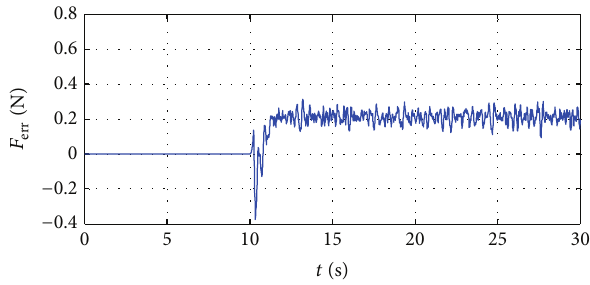
Figure 8: (a) Position tracking errors along the z -axis. (b) The interaction force along the z -axis.